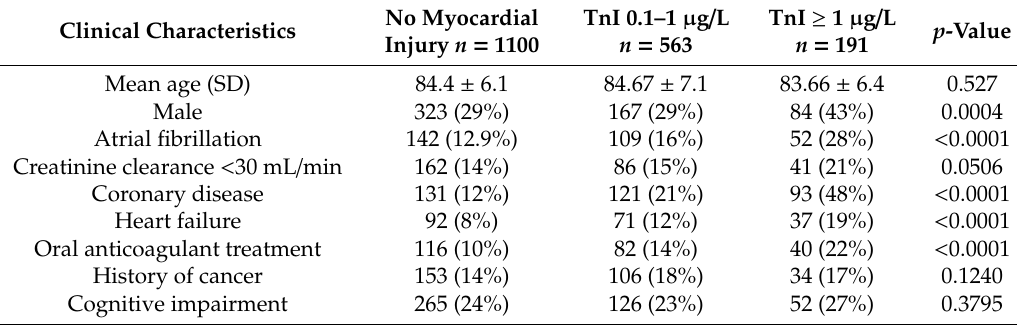
Table 1. Demographic and clinical characteristics of the three groups under study.